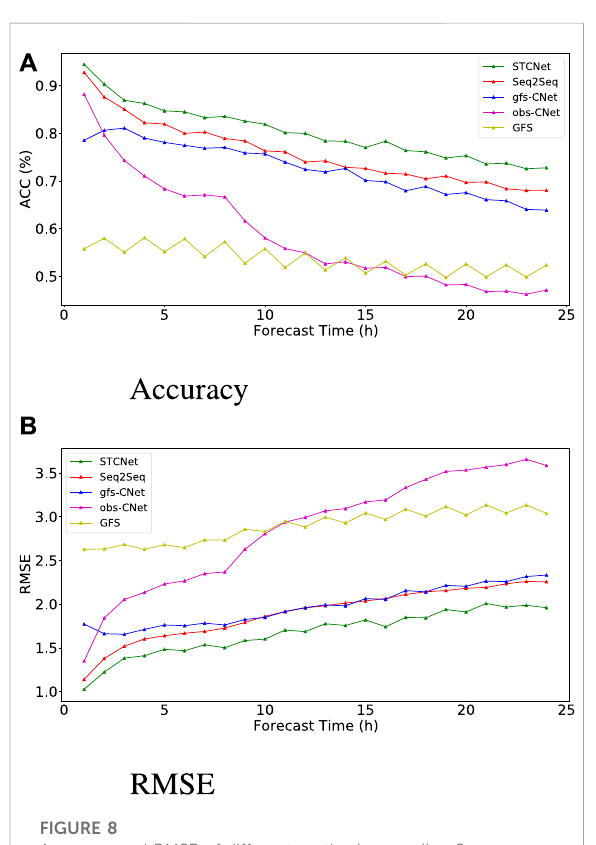
FIGURE 9 Accuracy and RMSE of different methods regarding 2-m dewpoint temperature forecast with respect to forecast